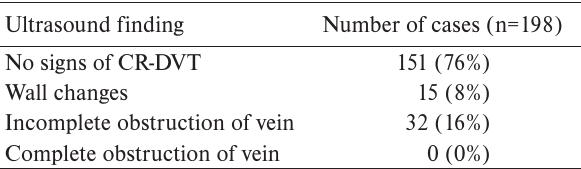
Table 4. Results of ultrasound imaging.